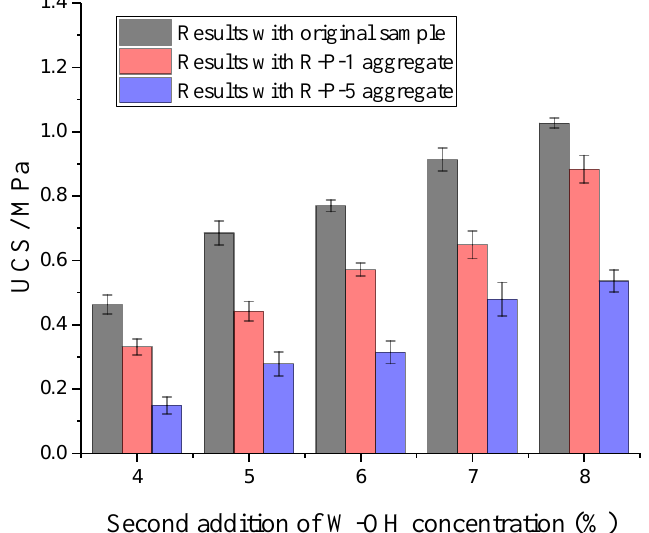
Table 2. Relationship between the W-OH concentration and the unconfined compressive strength of the original Pisha stone/W-OH composites. Figure 4. Indication of the samples after compressive strength tests. ( a ) Demonstration of the crushed samples with original (0), R-P-1 (4) and R-P-5 (8) type aggregates; ( b ) test setup for the compressive strength examination.